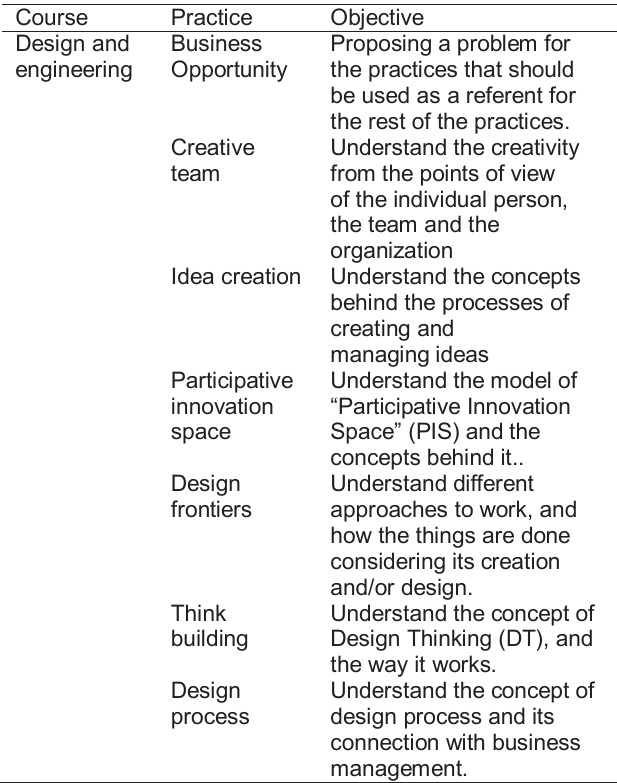
Table 6. Practices applied for empirical experience